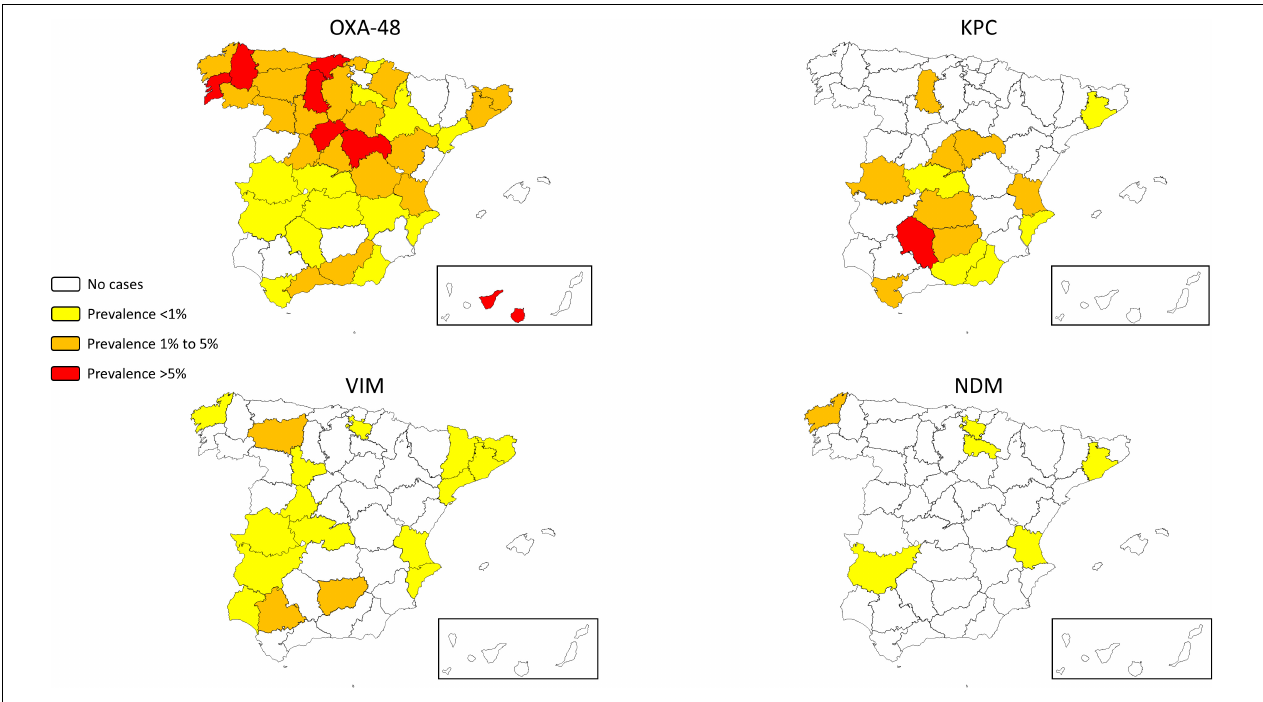
FIGURE 1 | Geographical distribution of the prevalence of carbapenemase-producing Klebsiella pneumoniae according to carbapenemase groups.